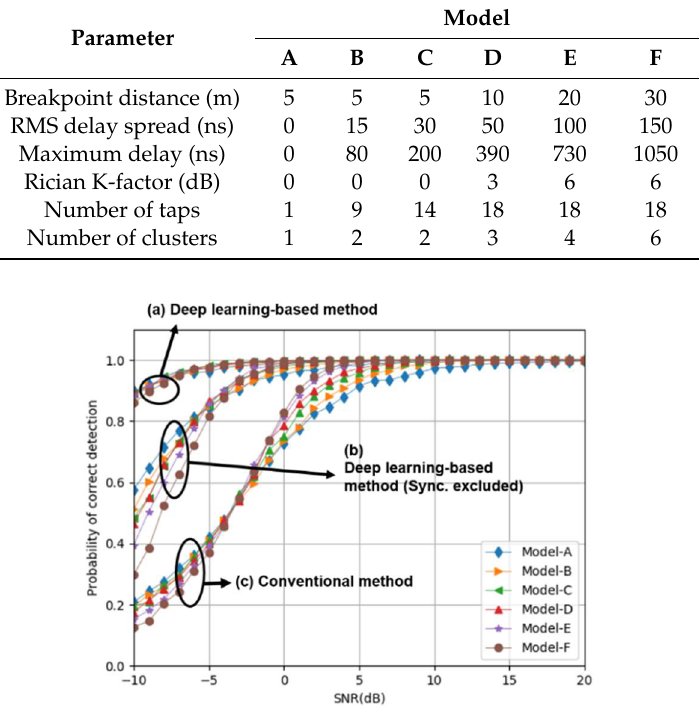
Figure 6. Format detection performances: (a) proposed deep learning method, (b) deep learning with symbol synchronization provided by the conventional method, and (c) conventional method based on symbol synchronization and channel estimation (CE)/channel compensation.